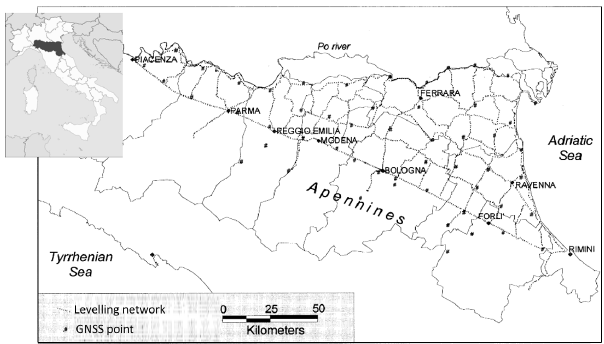
Figure 1. Levelling network and GNSS points for the 1999 cam-